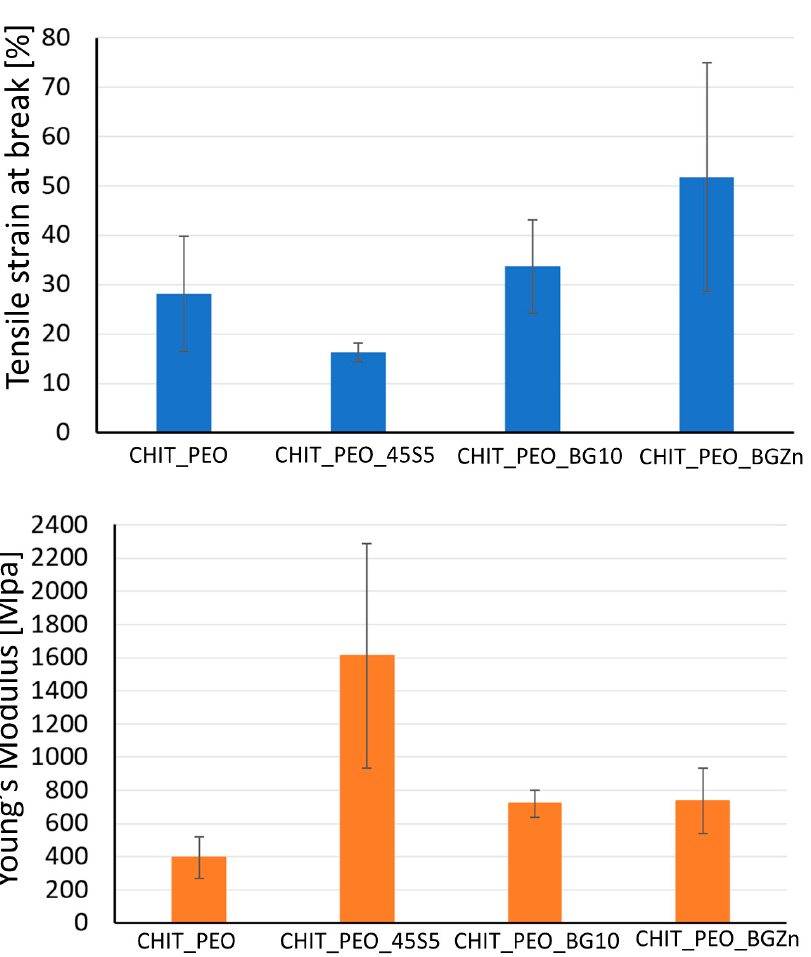
Figure 4. Tensile strain at break [%] and Young’s modulus [MPa] of CHIT_PEO, CHIT_PEO_45S5, CHIT_PEO_BGMS10 and CHIT_PEO_BGMS_2Zn.